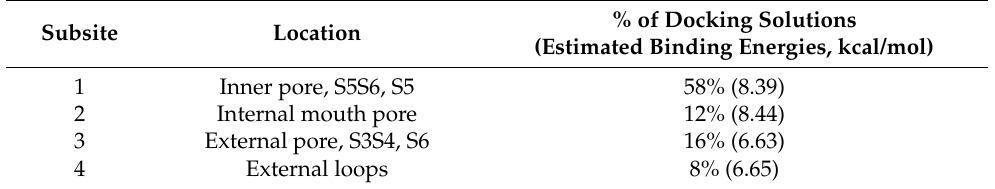
Table 3. Main sites found for compound RGM8-51 and statistical distribution of docking solutions. Subsite